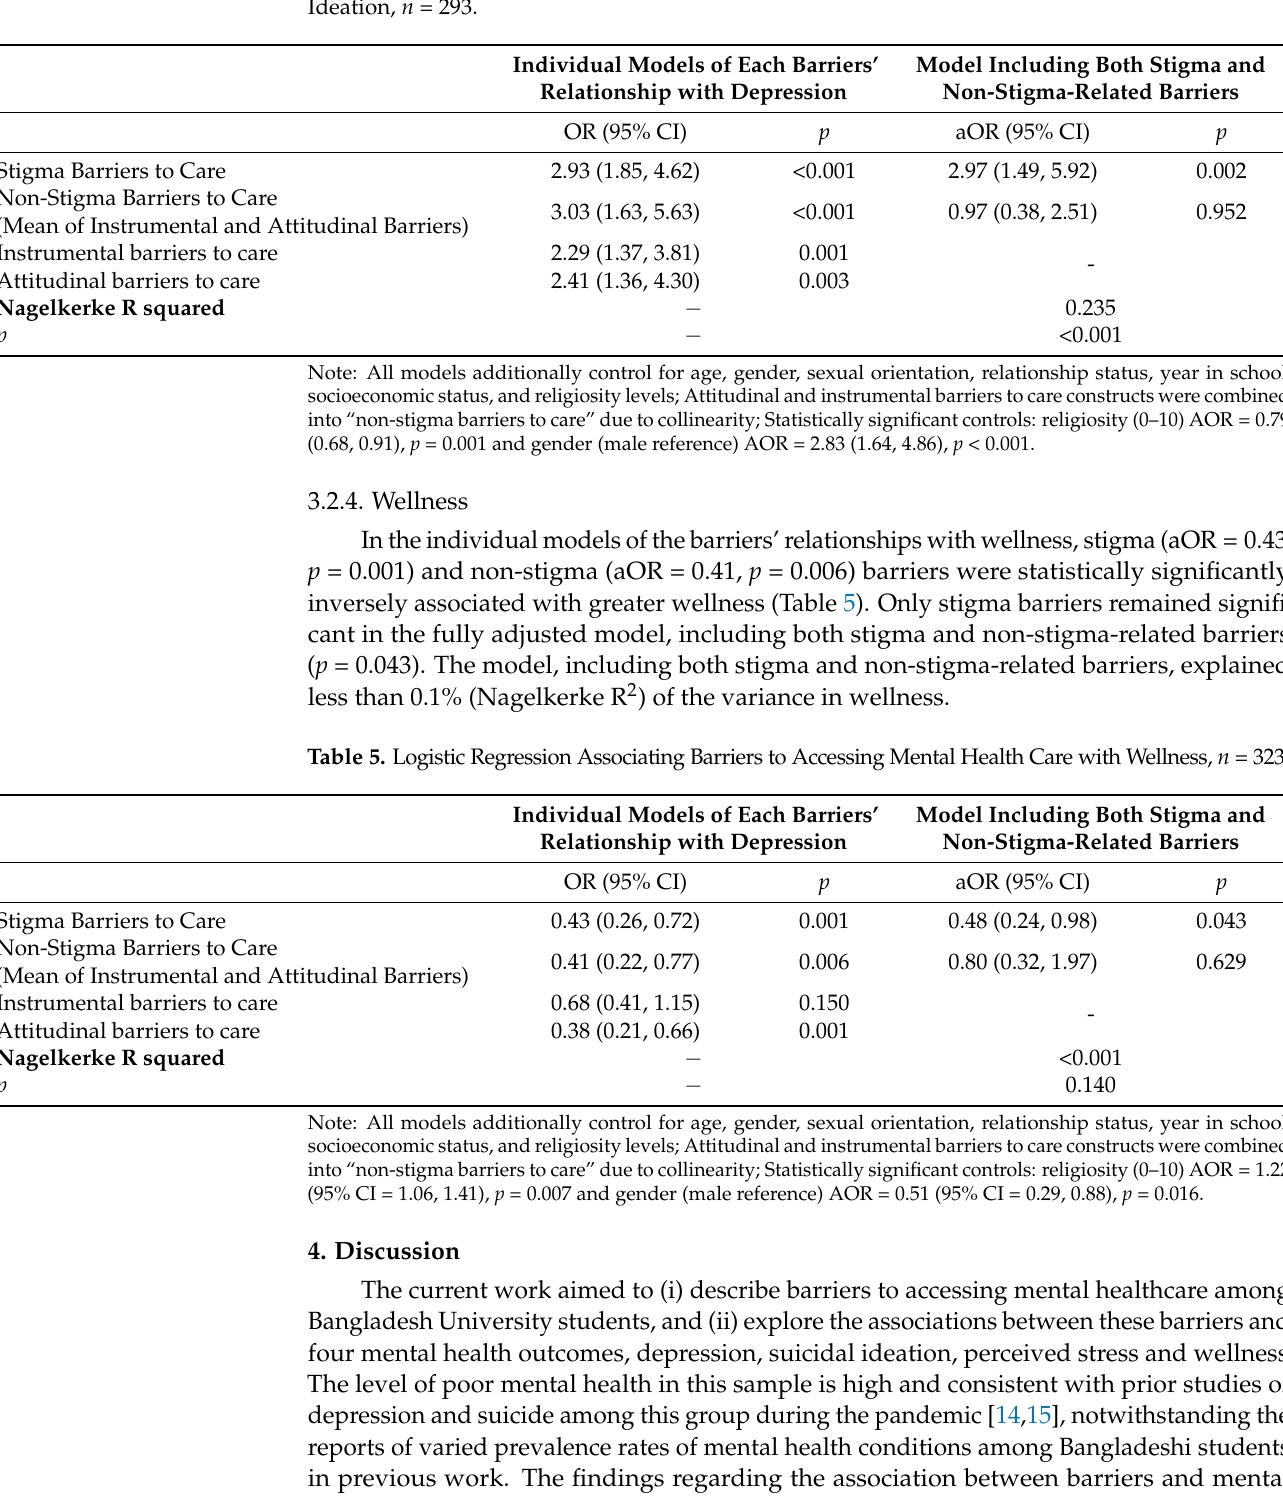
Table 4. Logistic Regression Associating Barriers to Accessing Mental Healthcare with Suicidal Ideation, n = 293.